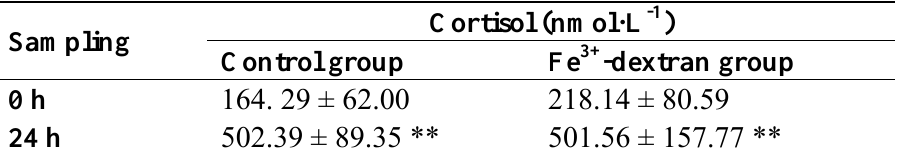
Table 3. Piglet serum cortisol concentrations (mean ± S.D.) prior to (0 h) and 24 hours after the administration of a single dose of Fe 3+ -dextran. (** p < 0.01), S.D.-standard